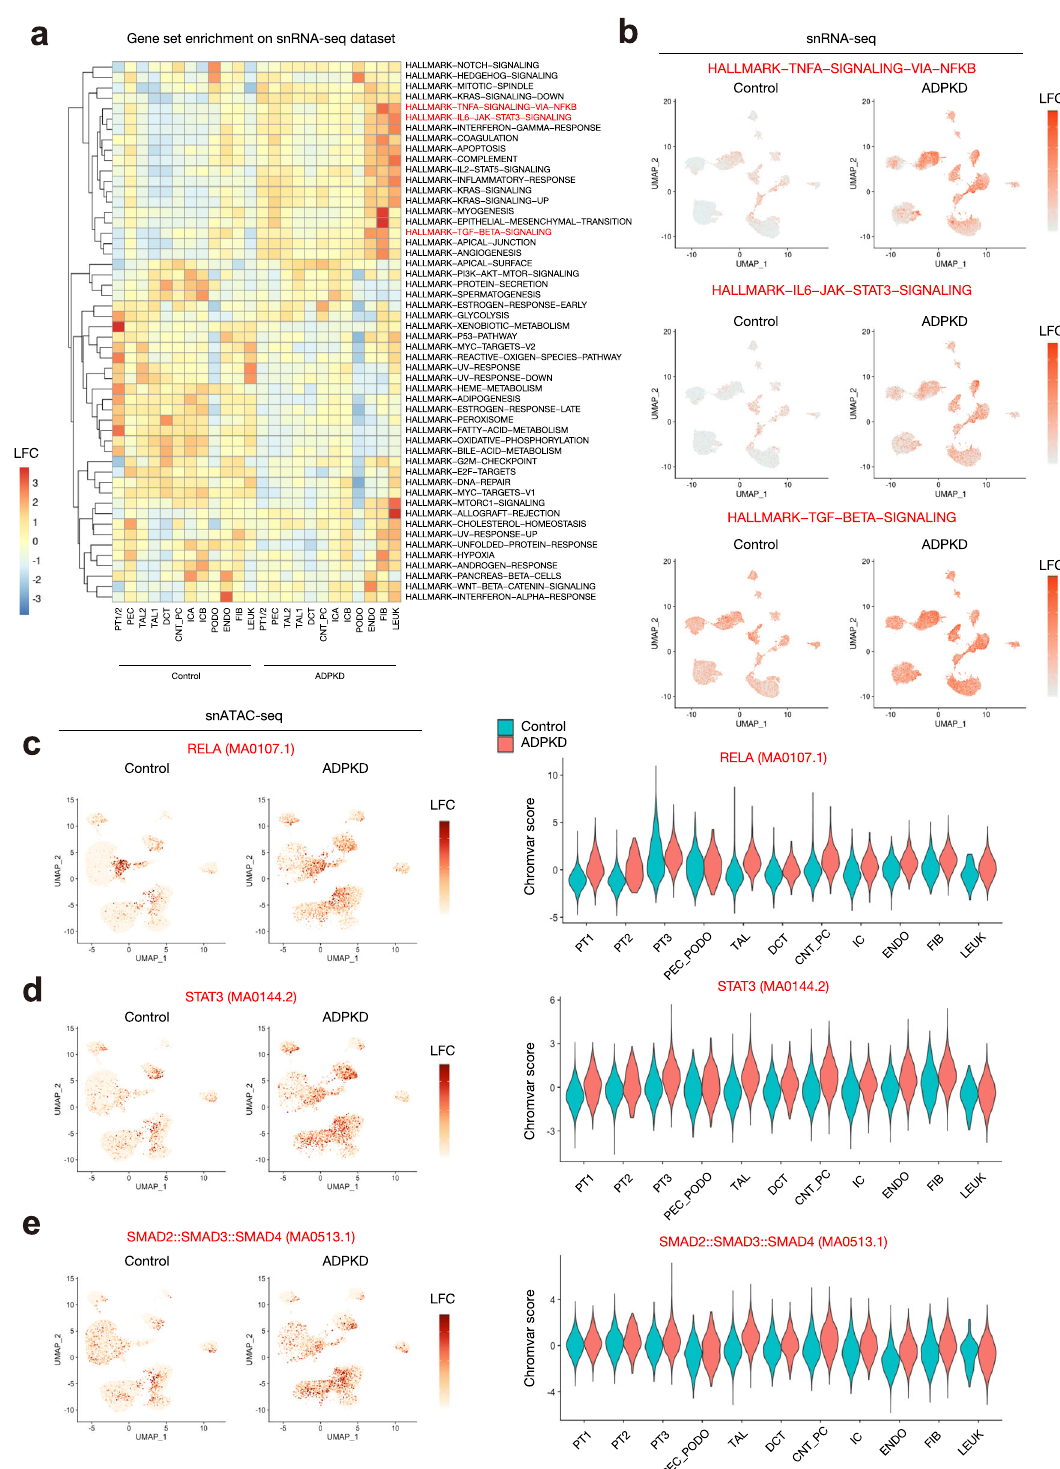
Fig. 3 | Activation of proin fl ammatory, pro fi brotic pathways in ADPKD kid- neys. a Heatmap showing enrichment of hallmark genesets of the Molecular Sig- natures Database (MsigDB) in each cell type of ADPKD or control kidneys. Source data are provided as a Source Data fi le. b UMAP displaying enrichment of genes regulatedbyNF- κ BpathwayinresponsetoTNF α (upper),genesupregulatedbyIL6 via STAT3 (middle) or genes upregulated in response to TGF β signaling (lower) in